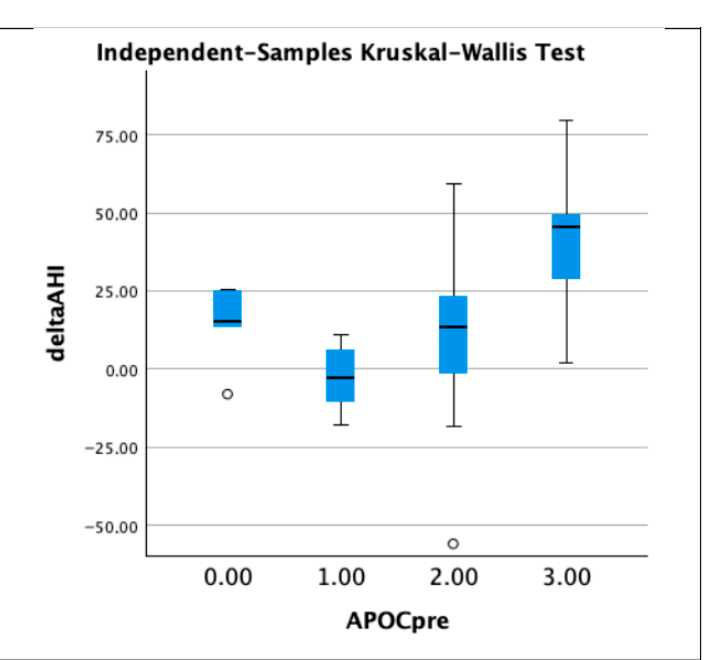
Figure 2. Linear regression graphs showing the relationship between preoperative AHI and delta ‐ AHI.